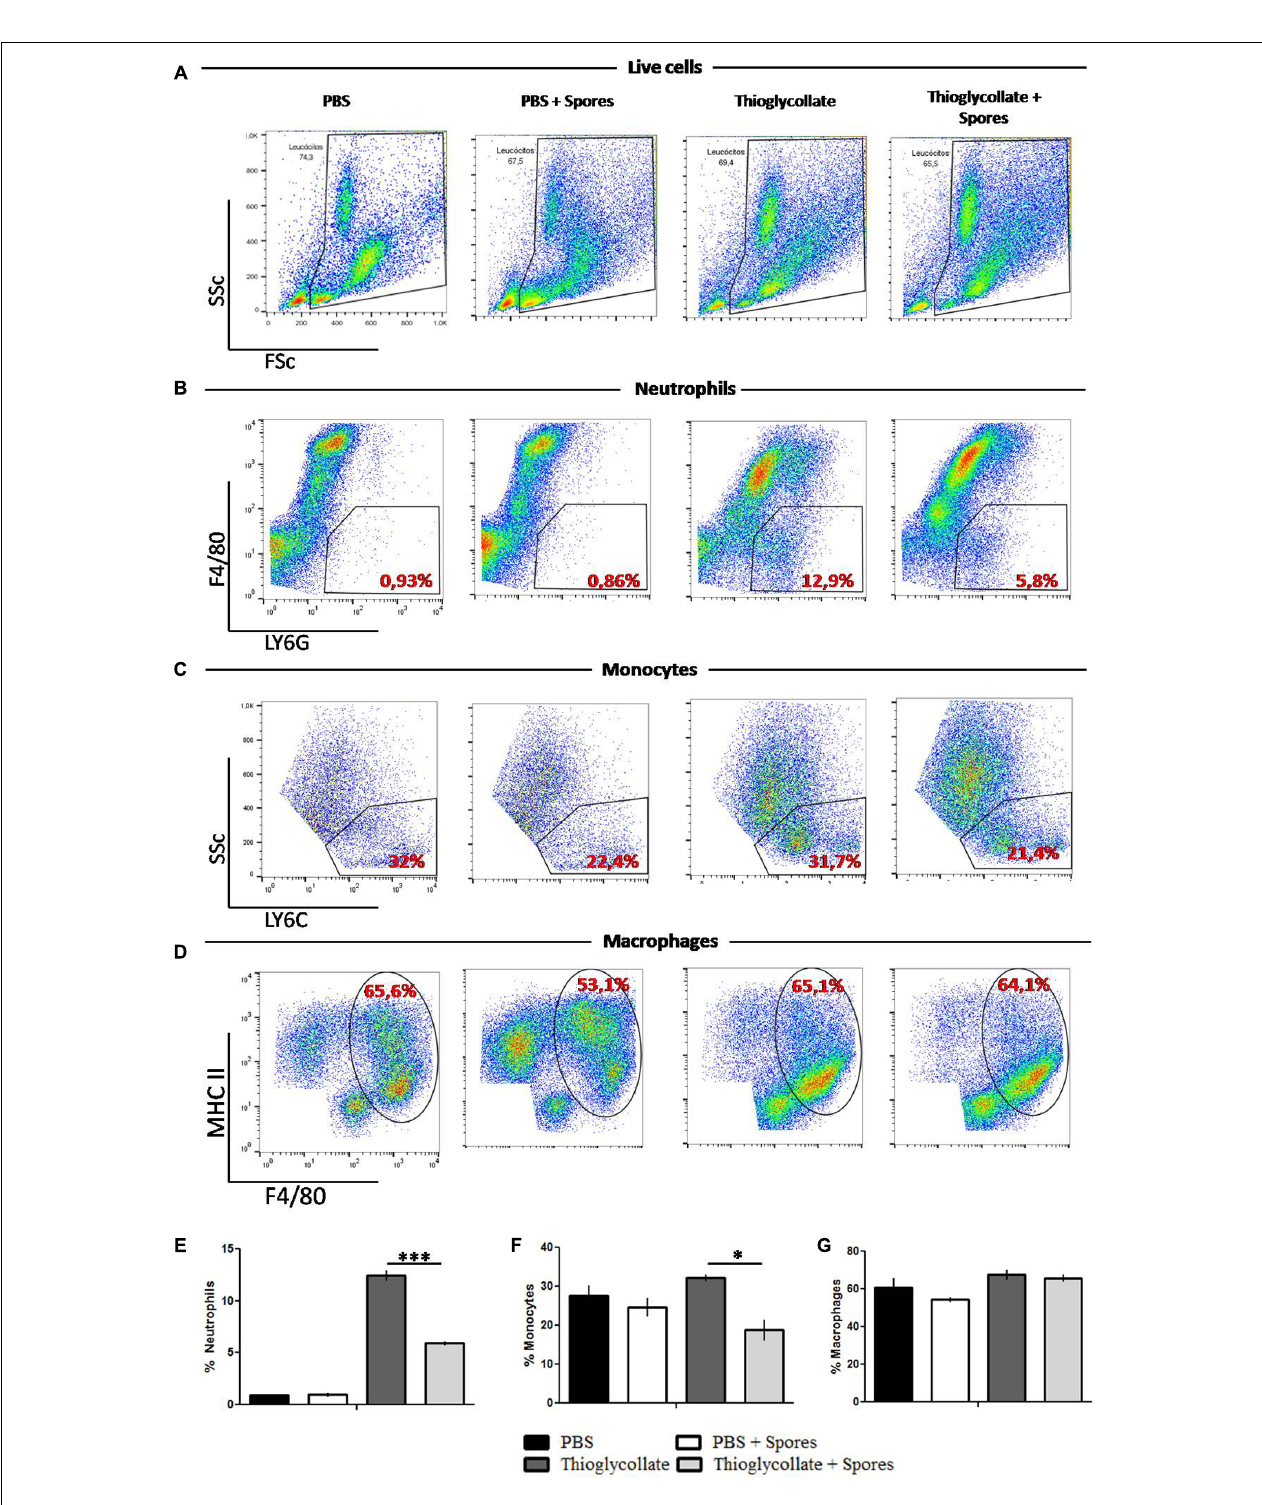
FIGURE 2 | Peritoneal white cells characterization. Cells were obtained from mice peritoneal cavity treated with PBS, PBS + spores, thioglycollate or thioglycollate + spores. (A) Gating strategy used to identify specific cell subtypes. (B) Different gating strategies to identify neutrophils (LY6G + F4/80 − ), (C) monocytes (LY6C), (D) macrophages (MHC II + F4/80 + ). Numbers on the dot plots represent percentages of the parental cell population. (E) Bars from the graphic represent the frequency of neutrophils, (F) monocytes and (G) macrophages from white blood cells from mice peritoneal cavity. Data show one histogram representative of three independent experiments with three mice in each group. Results are represented as mean ± SD. ∗ p ≤ 0.05, ∗∗∗ p ≤ 0.0001.